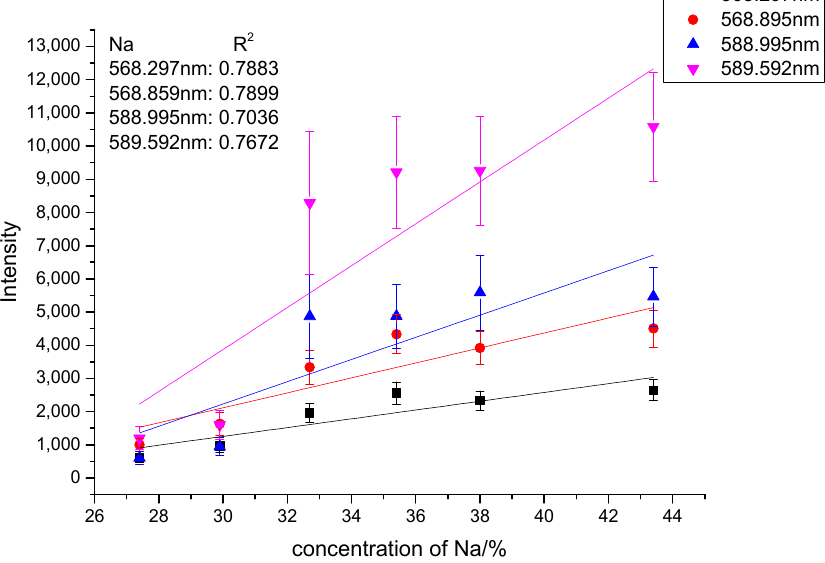
Figure 5. LIBS signal intensity of Na vs. Na concentration at a laser fluence of 3.8 J / cm 2 .